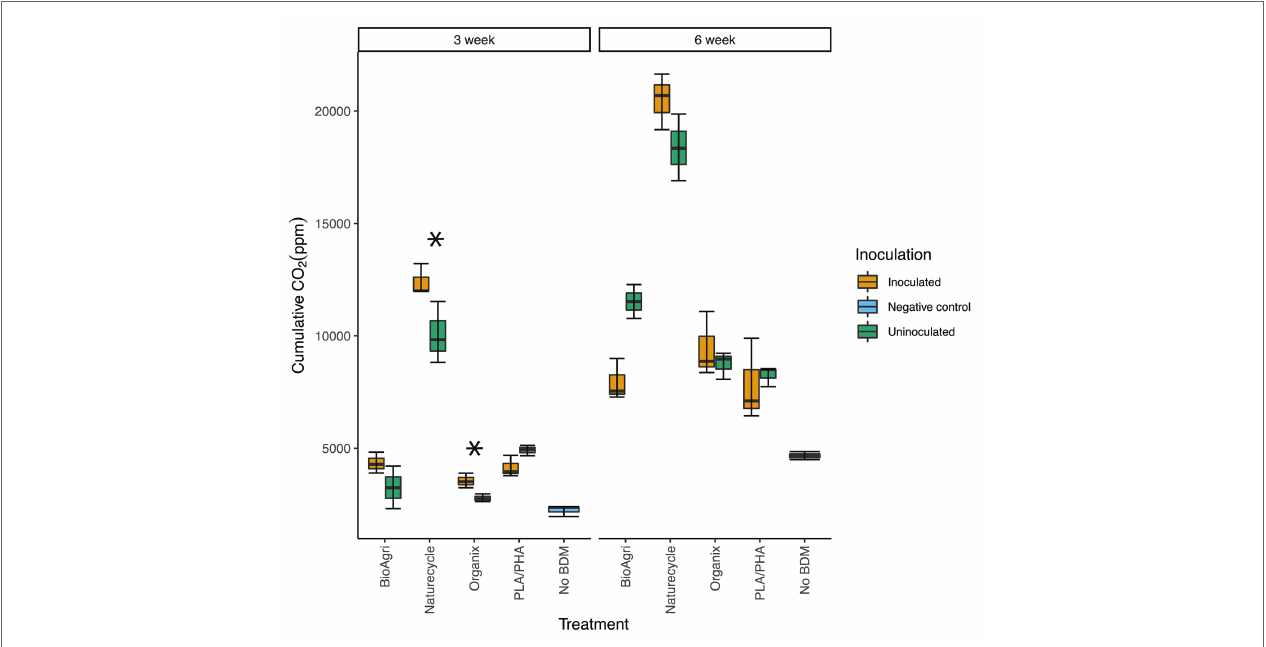
FIGURE 1 | Cumulative carbon dioxide (CO 2 ) measured in enrichment culture headspace gas after 3- and 6-week incubations. The lower and upper hinges of the boxplots correspond to the 25th and 75th percentiles and the middle of the box denotes the median. Whiskers denote 1.5 times the inter-quartile range. Asterisks indicate significant differences between uninoculated and inoculated enrichments from a t -test; * p ≤